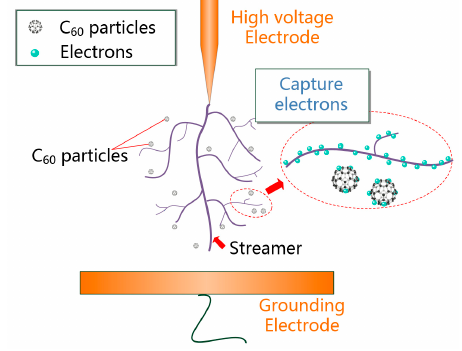
Figure 17. C 60 particles capture electrons involved in streamer formation.